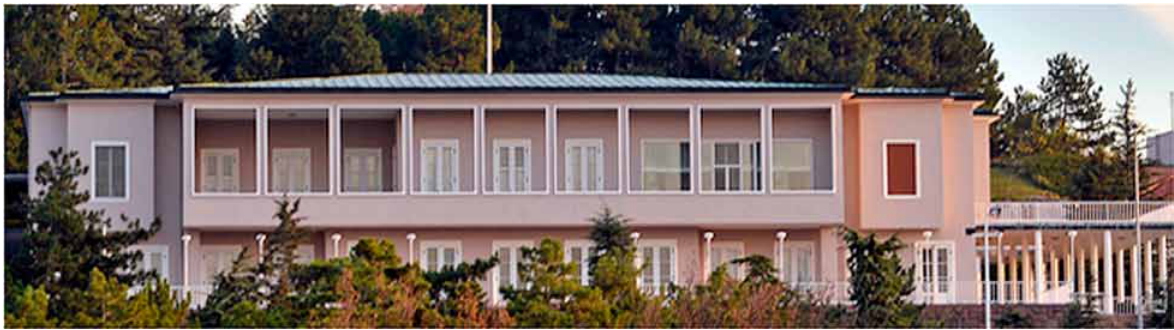
fig. 1. Cankaya Palace of Kemalist period by Holzmeister (Presidency of Turkish republic